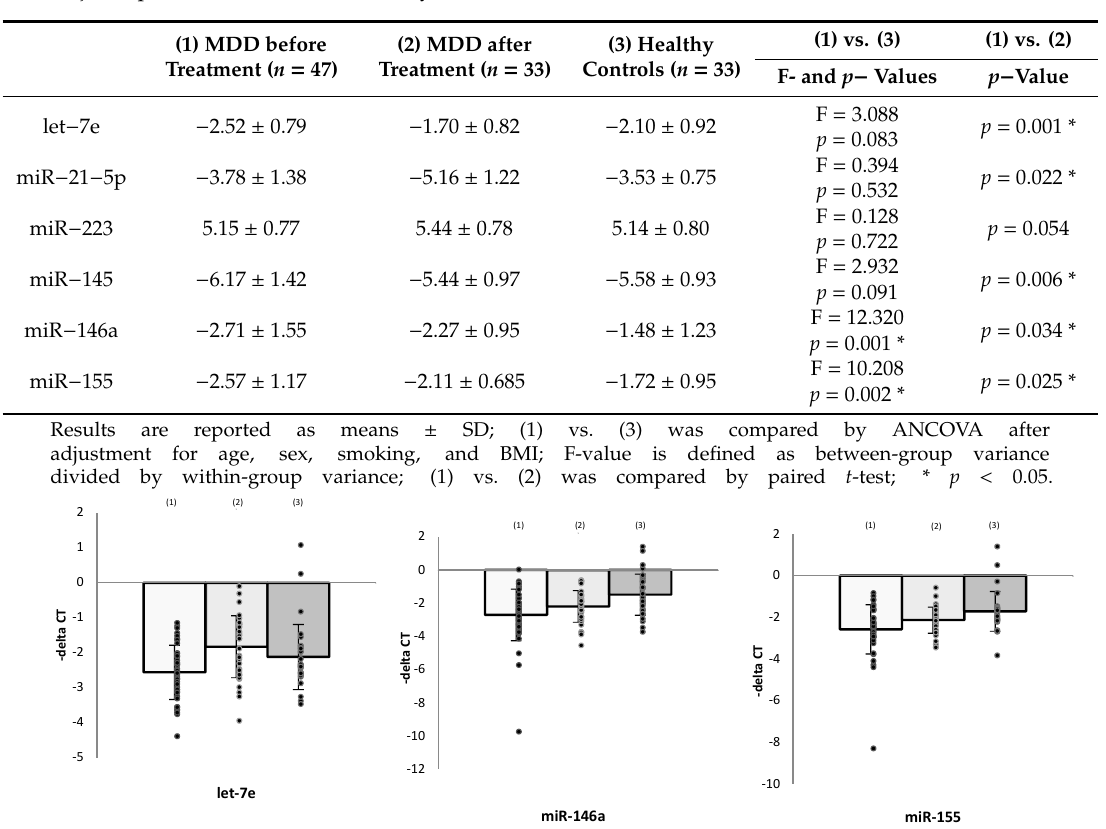
Table 3. Expression in monocytes of individual microRNAs regulating TLR signaling in patients with major depressive disorder and healthy controls.